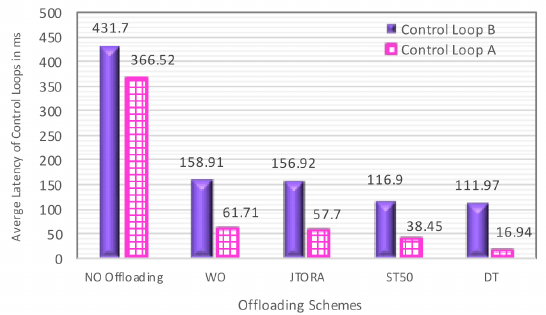
Figure 5. The Comparison of the Average Latency with Various Offloading Schemes.